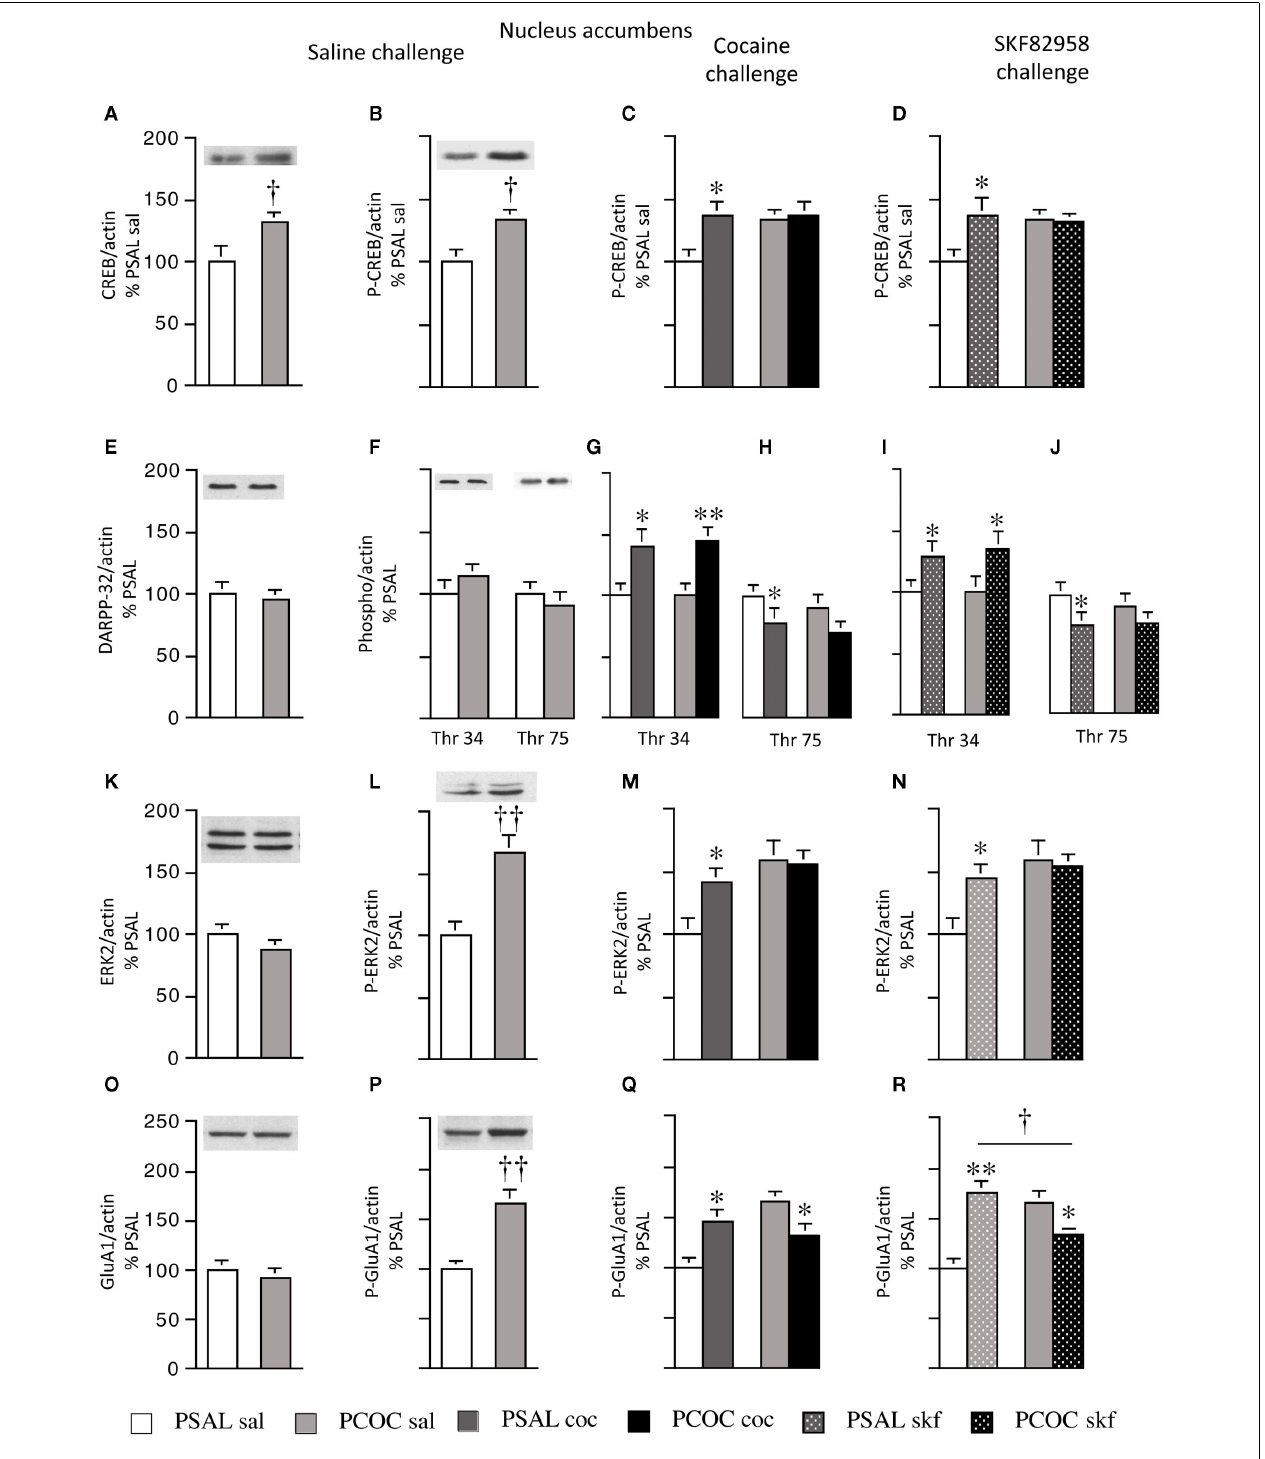
treated and prenatal cocaine (PCOC) treated mice administered normal saline (sal), cocaine (15mg/kg; coc) or D1 agonist, SKF 82958 (1mg/kg; skf) as adults. Data are represented as percentage of PSAL mice treated with saline (PSAL sal). † p < 0.05, †† p < 0.01 PCOC pretreatment groups vs. PSAL pretreatment groups. * p < 0.05, ** p < 0.01, coc or skf treated mice vs. sal treated mice within the same prenatal treatment. Error bars represent ± SEM. N = 6–8